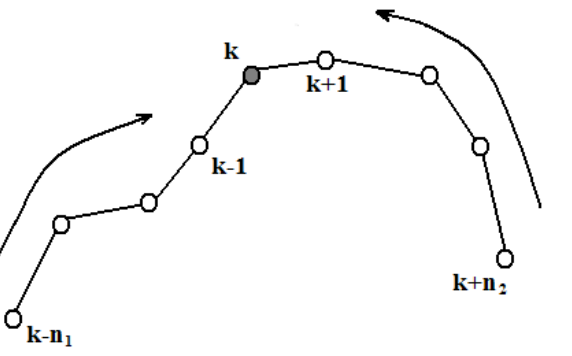
Figure 1. The Fixed Interval